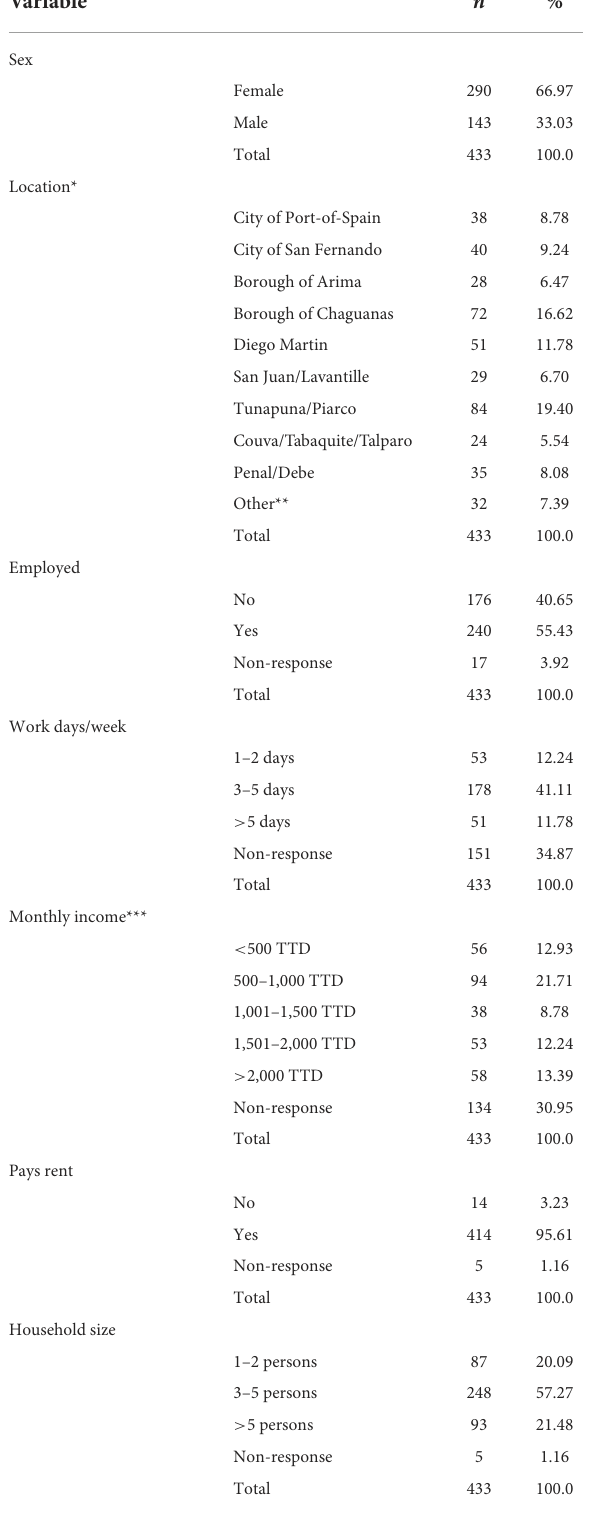
Table 4 summarizes the univariate associations of sociodemographic and economic characteristics with food insecurity in terms of unadjusted odds ratios with 95% confidence intervals; while Table 5 summarizes the multivariate associations of sociodemographic and economic characteristics with food insecurity in terms of adjusted odds ratios with 95% confidence